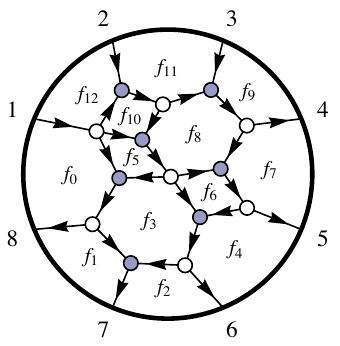
Figure 2 . A plabic graph associated to the 12-dimensional cell in G + (3 , 8) labeled by the decorated permutation { 4 , 5 , 7 , 6 , 9 , 8 , 11 , 10 } . The cubic symbol letter h ¯4 ∩ (467) ∩ ¯2 ∩ (278) i appears in the solution of C Z = 0 after performing a non-square move mutation on face f